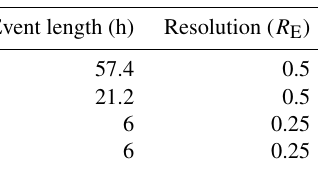
Table 1. Summary of the event simulations within the current